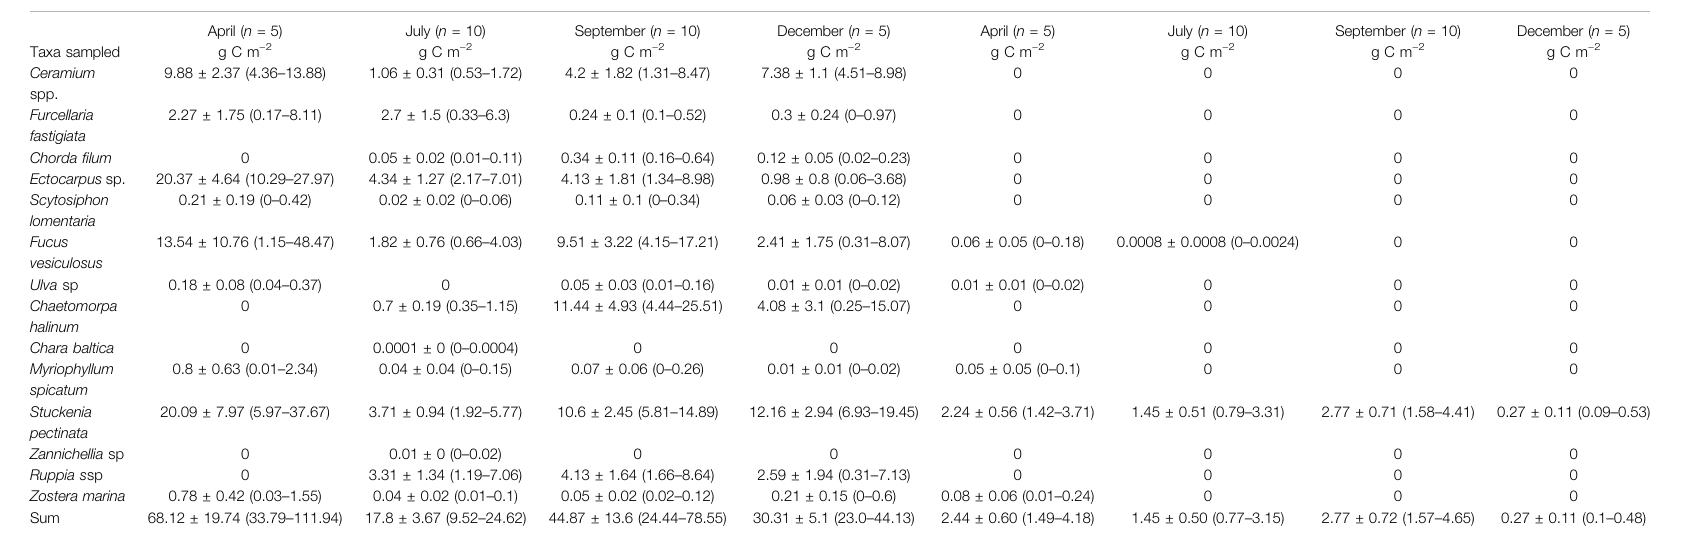
TABLE 3 | Macrophytobenthic biomass in Vitter Bodden and Grabow sampled by drop trap.